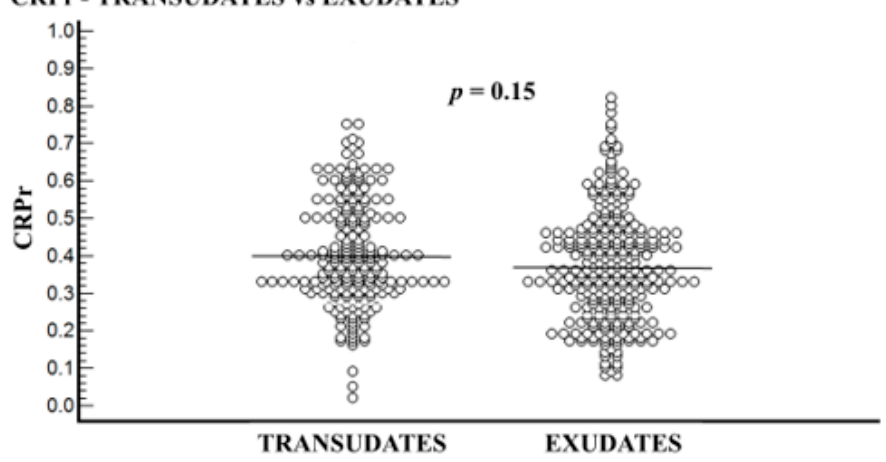
Figure 4. Pleural fluid to serum CRP ratio (CRPr) levels and their means for transudate group (4.0) and exudate group (0.37). No significant difference was found between the two groups ( p = 0.15). The best cut-off values for CRPs, CRPpf, and CRPg, which were calculated by the ROC analysis for discriminating transudative from exudative PEs, together with their relevant statistical parameters, are presented in Figures 1–3 and 5–7.